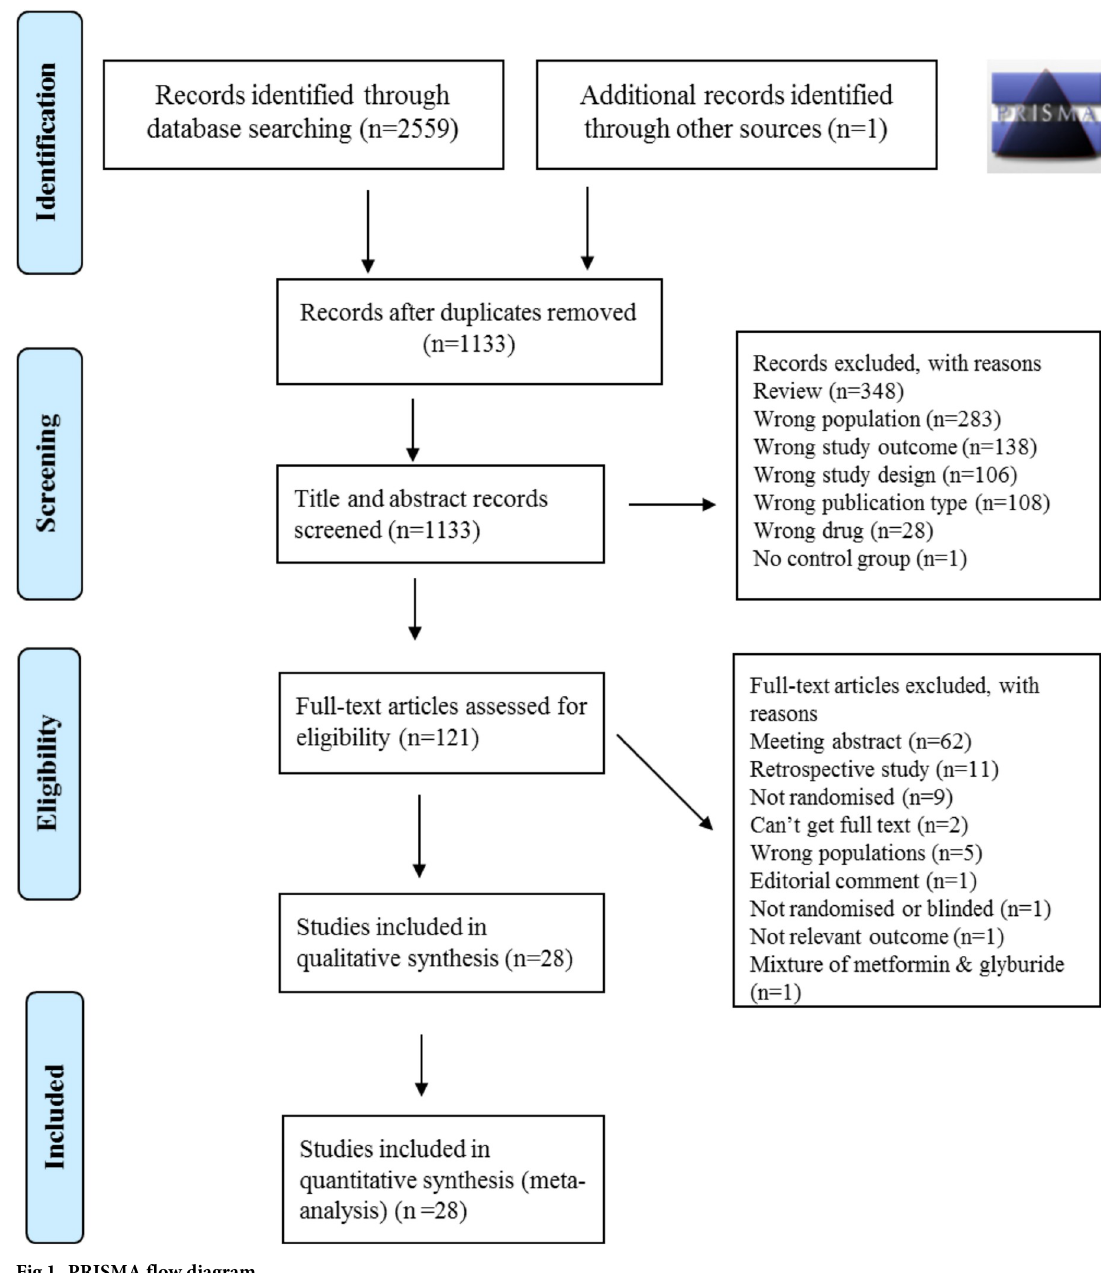
Fig 1. PRISMA flow